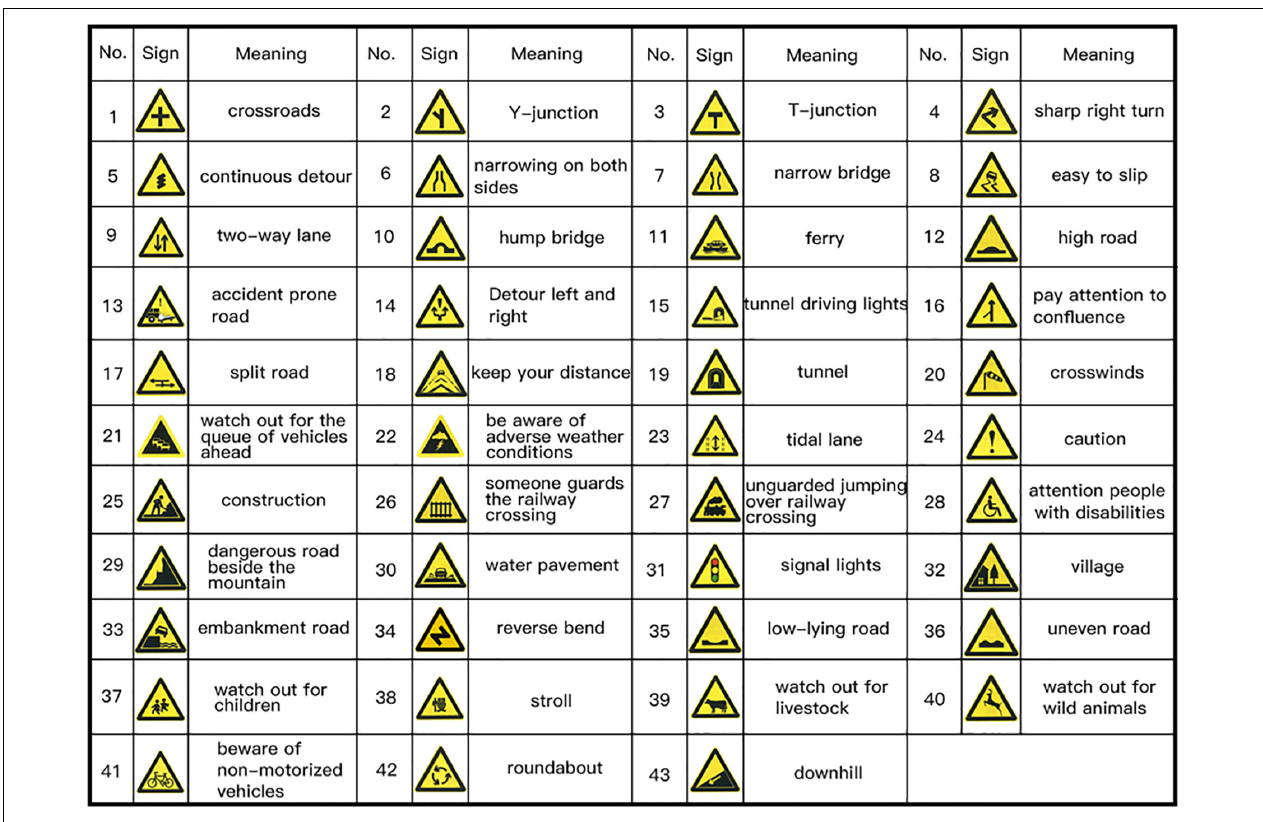
FIGURE 3 | Preliminary screening of 43 traffic warning signs.